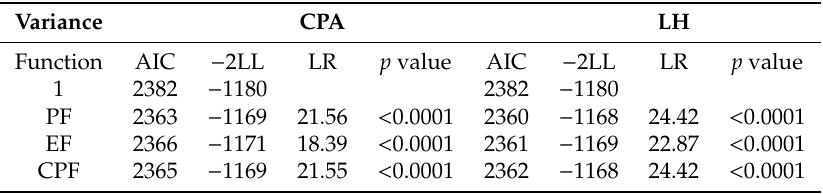
Table A1. Assessment of the nonlinear mixed-e ff ects diameter at breast height model (18) with di ff erent variance functions (CPA, crown projection area (m 2 ); LH, LiDAR derived tree height (m); AIC, Akaike’s information criterion; LL, log-likelihood; LR, likelihood ratio; EF, exponential function – Equation (13); PF, power function – Equation (14); CPF, constant plus power function – Equation (15); and variance function 1 meant that the variances were